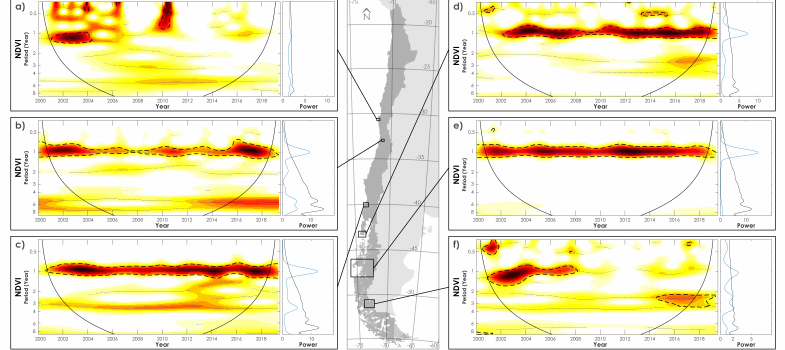
Figure A1. Wavelet analysis of NDVI monthly data between 2000 and 2018 in ( a ) Fray Jorge, ( b ) La Campana, ( c ) Alerce Costero, ( d ) Tantauco, ( e ) San Rafael and ( f ) Torres del Paine. The left panels show the local wavelet power spectrum. The color code for power values is from white (low power values) to dark red (high power values). The dot-black lines indicate the 95% significant areas obtained by adapted bootstrapping [57] and the cone of influence (bold-black lines) indicates the wavelet domain where computations are not influenced by edge effects (see [56]). The right panels show the global wavelet power spectrum for the period examined (2000–2018), with the black line showing a 95% confidence interval obtained by adaptive